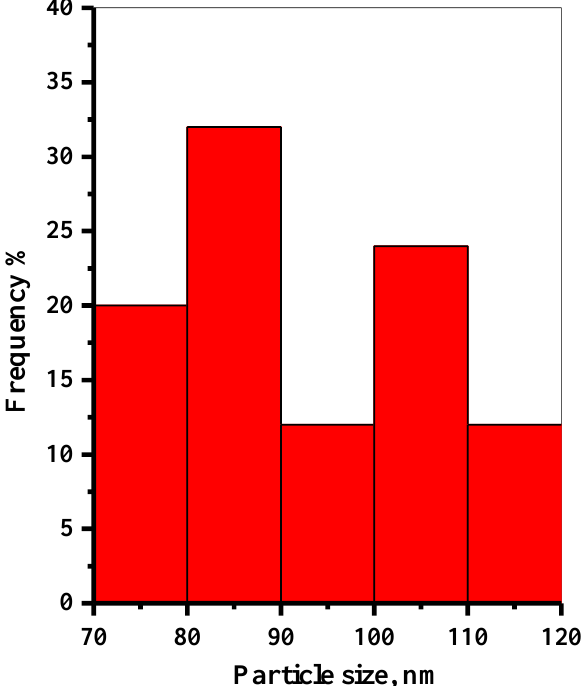
Figure 1. Histogram for the particle size distributions of the prepared P@SiO 2 -nanoparticles. FTIR spectra of silica and P@SiO 2 nanocomposite were investigated to obtain the basic information that illustrates the chemical structures of the prepared adsorbent material, as shown in Figure